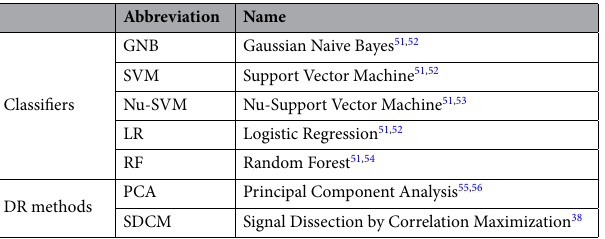
Table 1. Overview of selected classifiers and DR methods used for the generation of ML models.